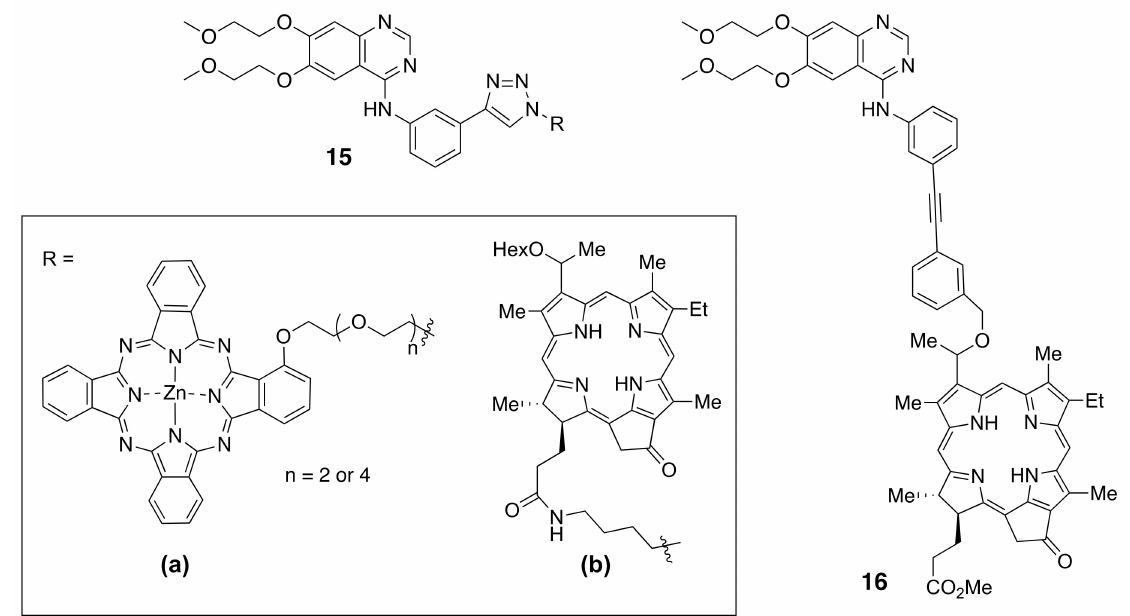
Figure 9. Structures of fluorophores conjugated to